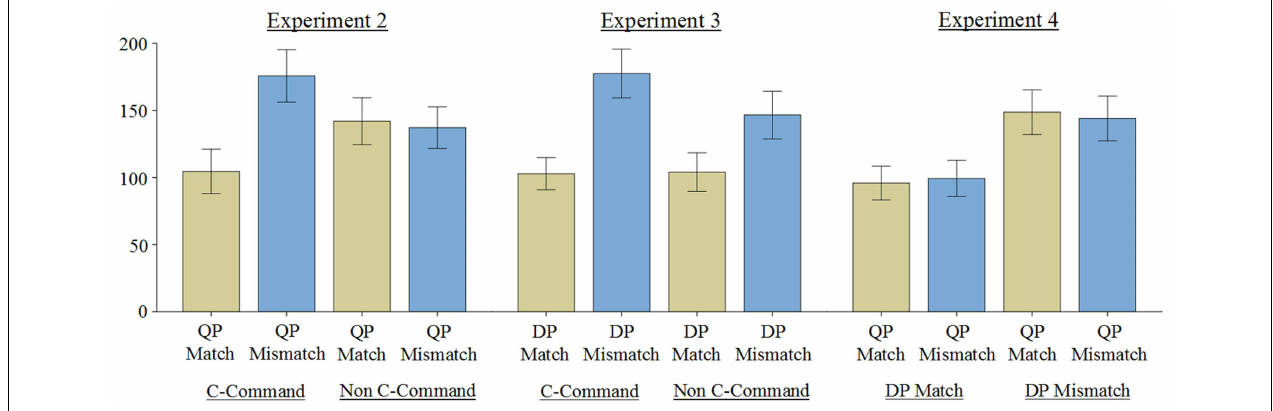
FIGURE 1 | Second pass times in milliseconds (with standard errors) at the pronoun region in Experiments 2–4.